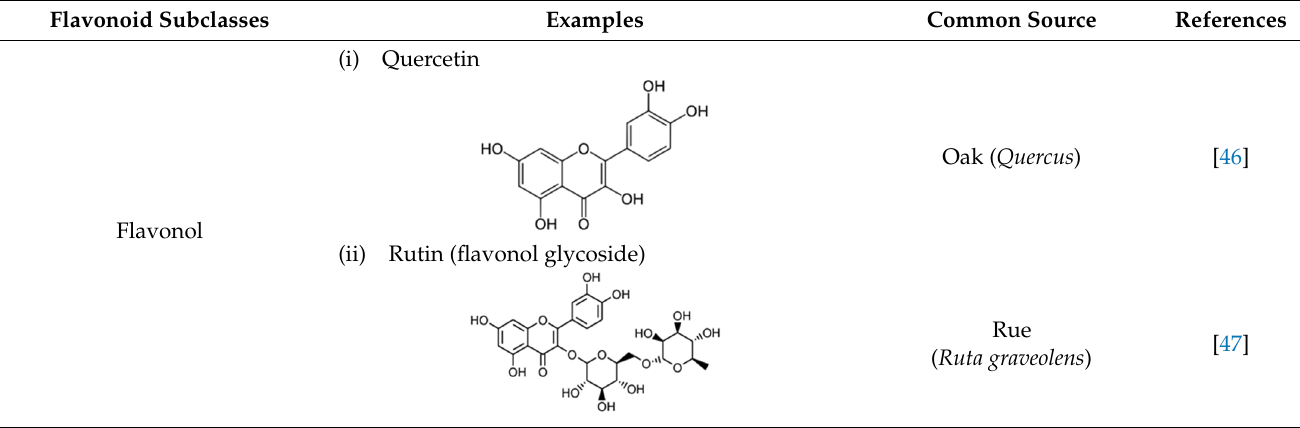
Figure 1. Basic chemical structure of flavonoids and their subclasses. Table 1. Chemical structure of flavonoid compounds and their respective common source.